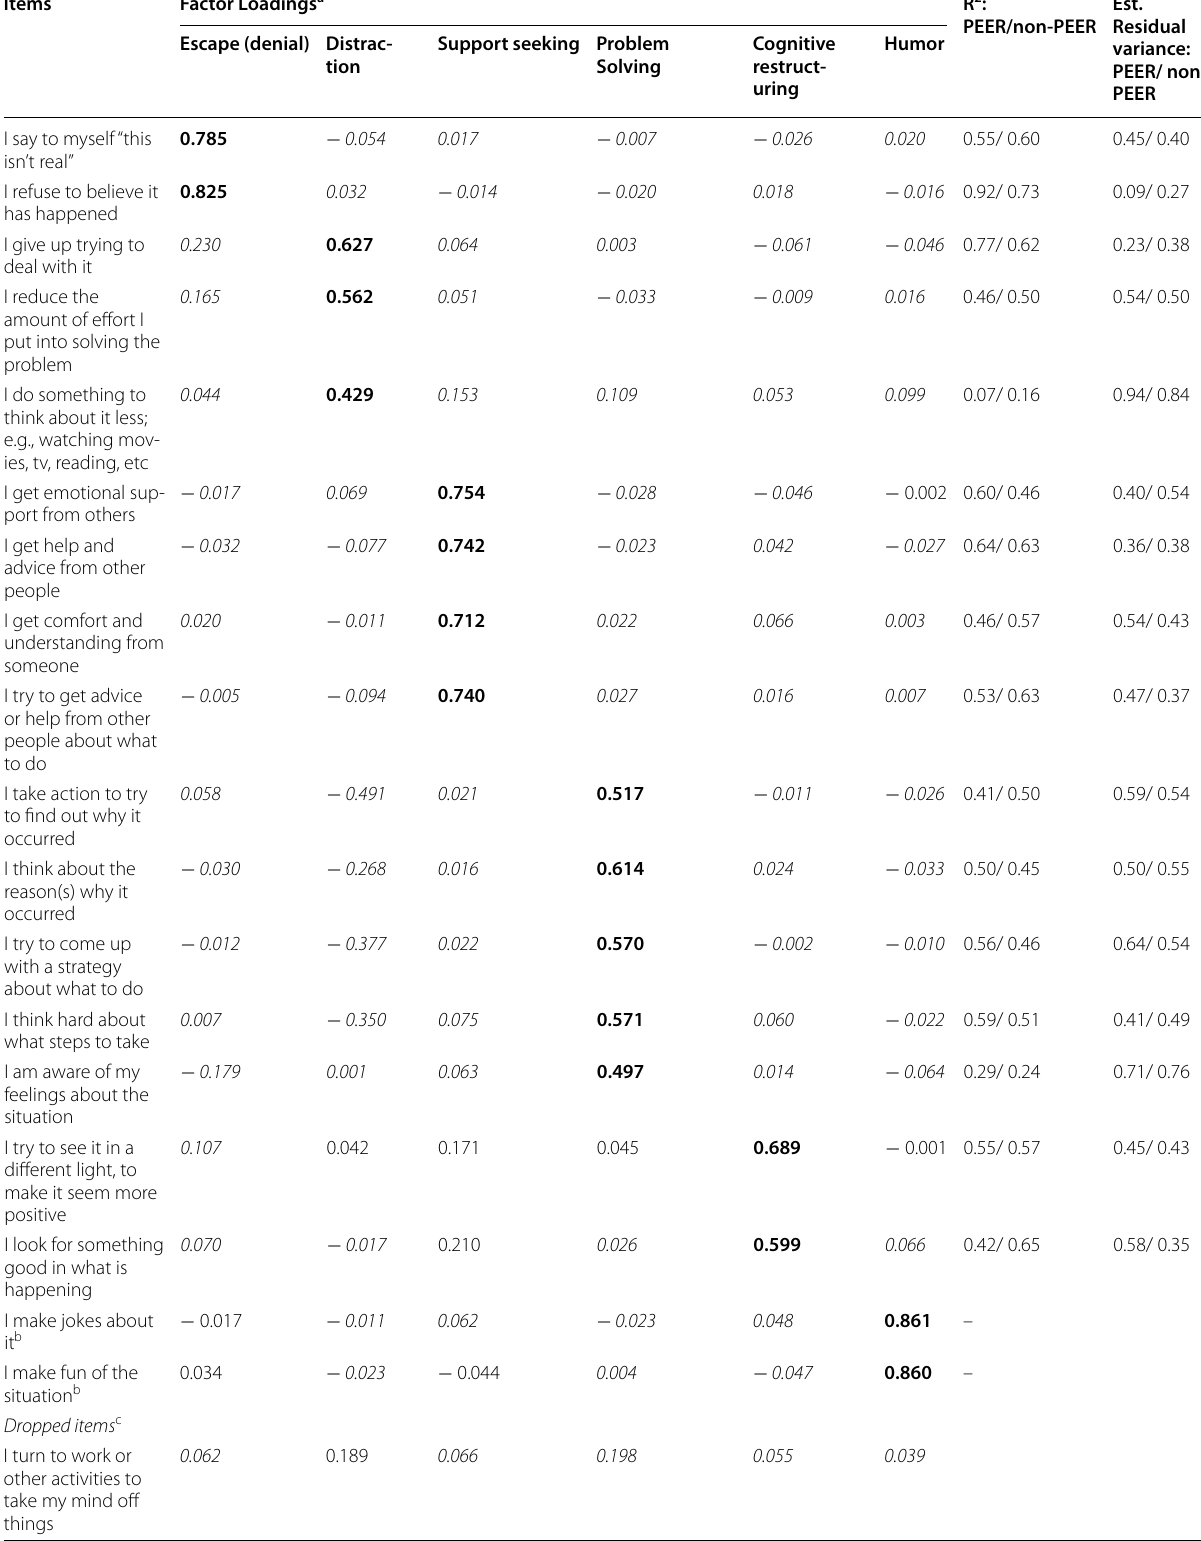
Table 3 Factor loadings for the coping behaviors